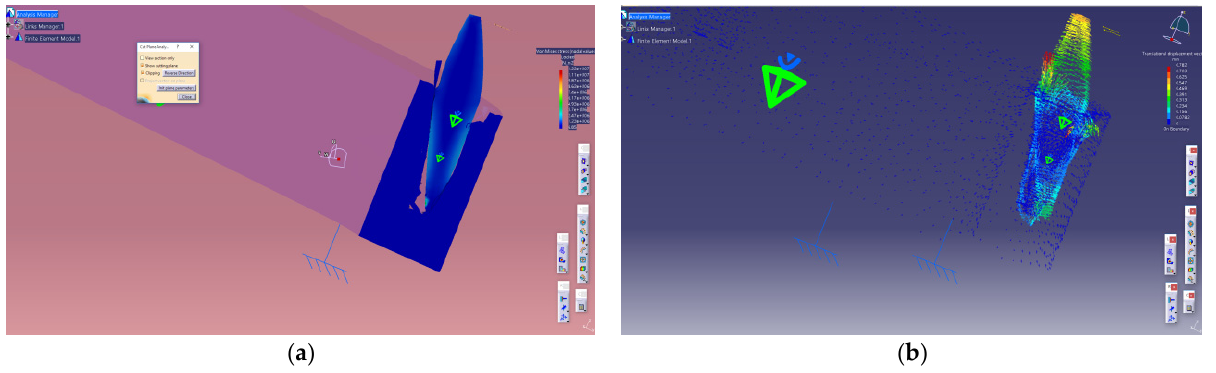
Figure 10. Lingualization of the LLI using a 1 N force: ( a ) von Mises tensions, 66% HBL; ( b ) tooth movement, 66% HBL.